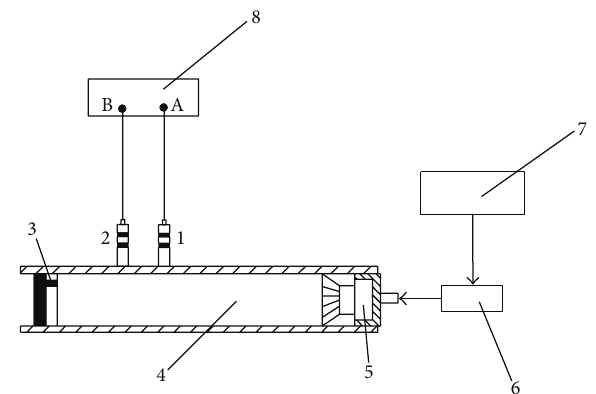
Figure 6: Example of the layout for the test equipment. (1) Microphone A, (2) microphone B, (3) test specimen, (4) impedance tube, (5) sound source, (6) amplifier, (7) signal generator, and (8) frequency analysis system.